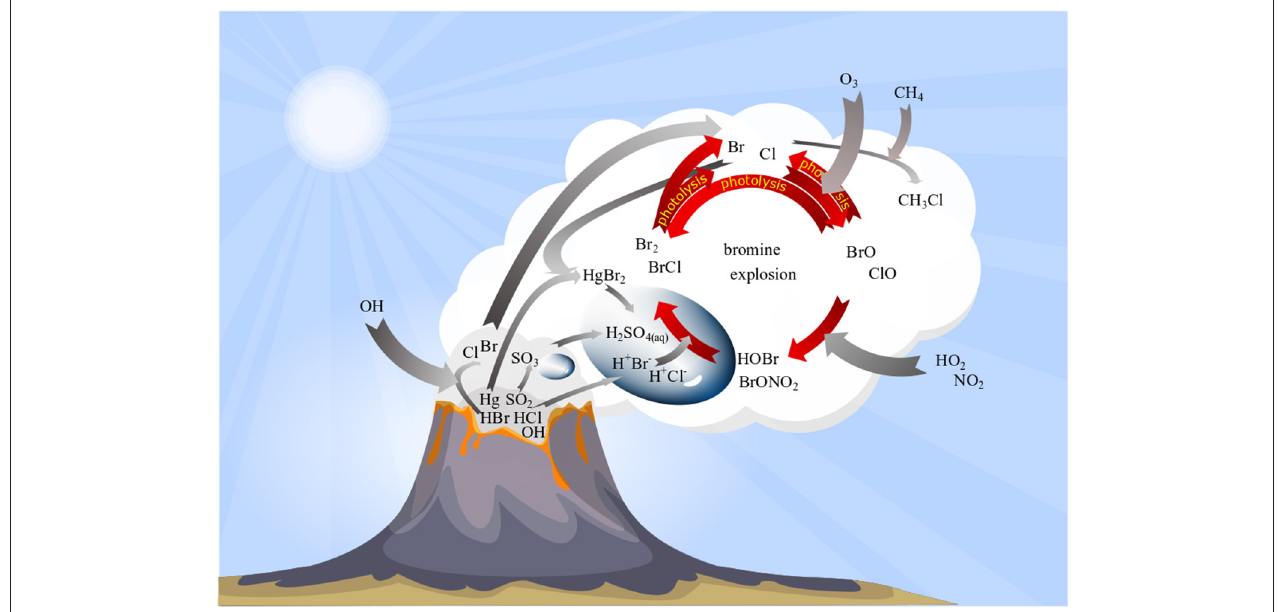
FIGURE 2 | Schematic overview on bromine plume chemistry. Volcanic emissions (dark gray cloud) are processed in high-temperature reactions forming minor amounts of halogen radicals (light gray cloud). Bromine radicals “kick-start” an autocatalytic cycle (“bromine explosion”) that converts emitted HBr into BrO via multistep reactions including gas and particle phase and leads to O 3 depletion (for details see section bromine